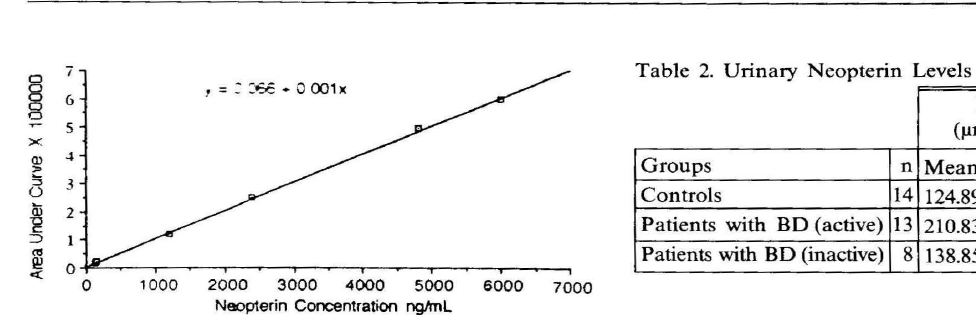
Table 2 Urinary Neopterin Levels of the